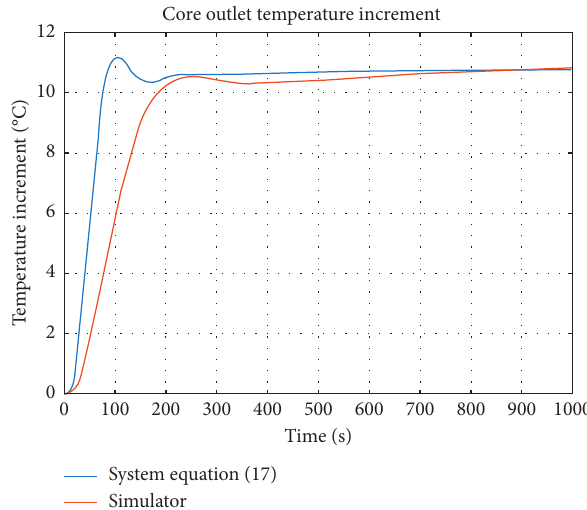
Figure 8: Core outlet temperature response of linear model equation (11) and CPR1000 simulator.